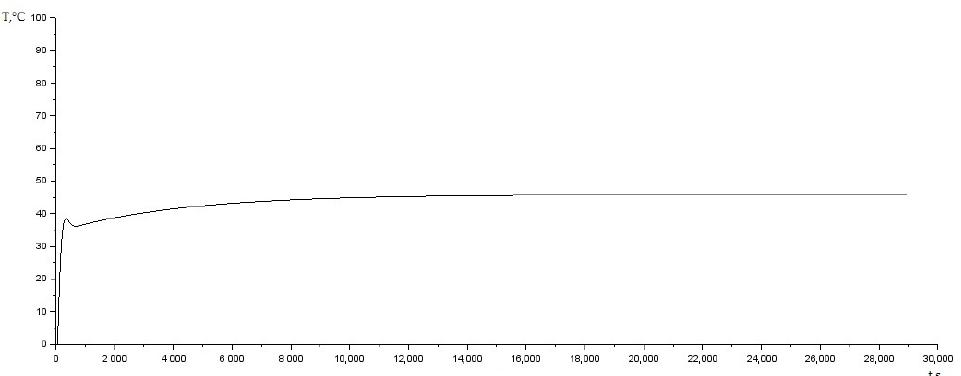
Figure 10. Transient characteristics of the model of the automatic control system of the temperature of heat carrier when the temperature of the water in the primary circuit changes (for a heat supply system with acoustic–magnetic devices).